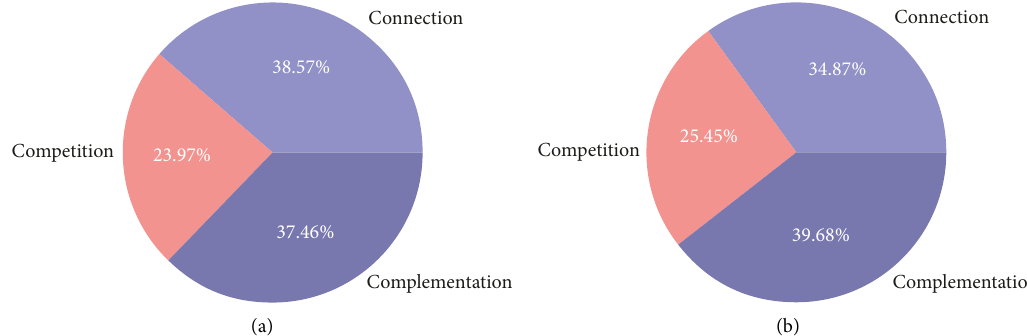
Figure 8: The share of connection, complementation, and competition trips. (a) Weekday. (b)